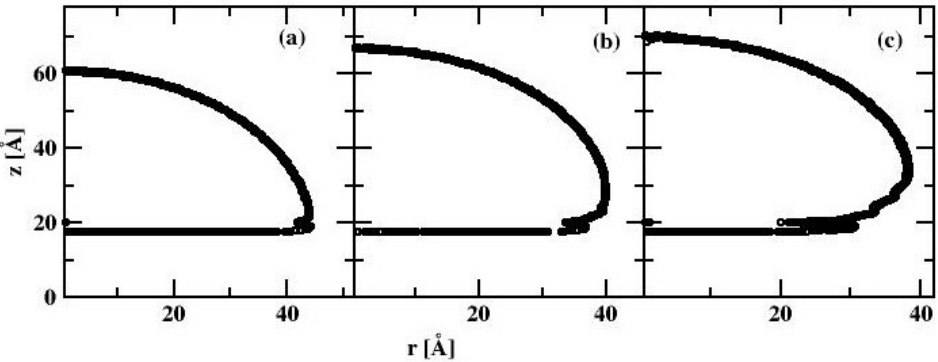
Figure 8. Simulation snapshots (side view) of water droplet on n-decane-covered silicon at C HYDR = 2.92 molec/nm 2 . The snapshot of the alkane on silicon before the water drop was introduced ( a ), the configurations of alkane molecules after the water drop was introduced (( b ) water molecules are not shown), and the snapshots of water drop with the alkane molecules ( c ). Silicon surface is not shown for better clarity.